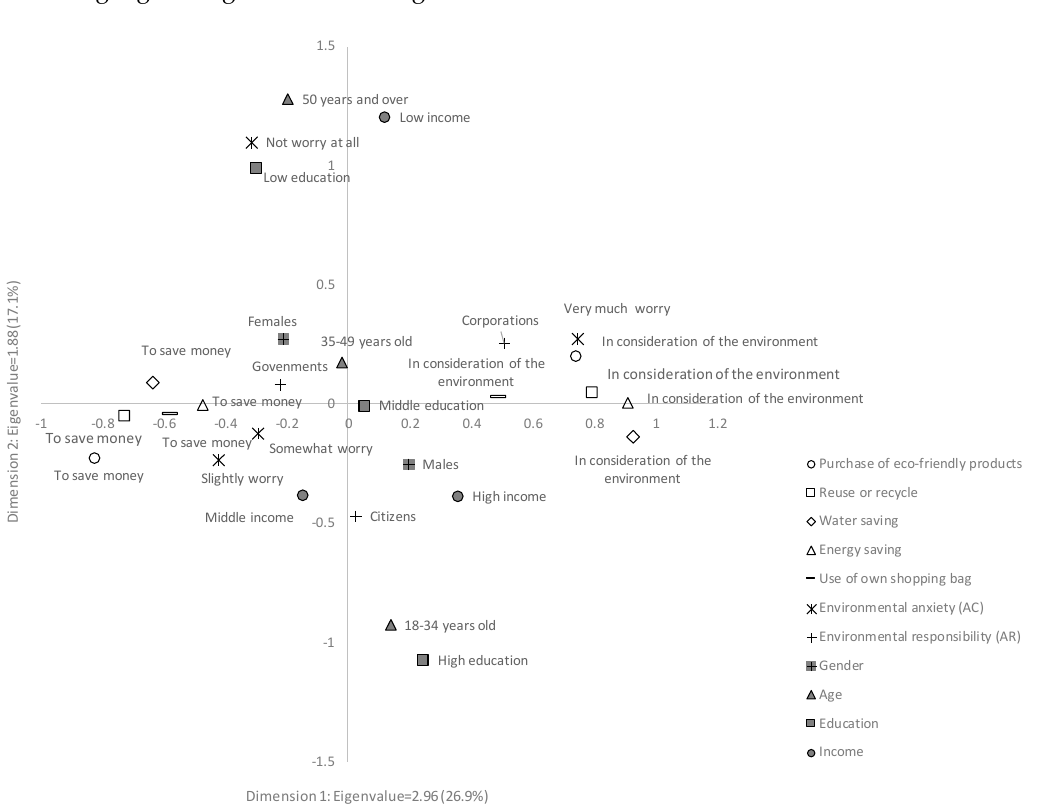
Figure 1. Multiple correspondence analysis of the relationship among motivations, AC, AR, and demographic factors.